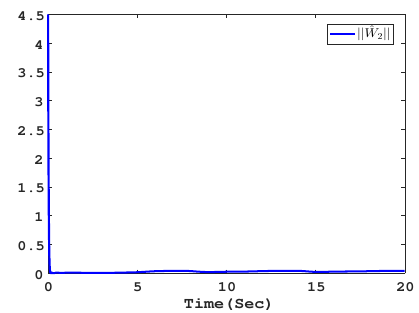
Figure 6. The trajectory of the norm for the NN weight ˆ W 2 .